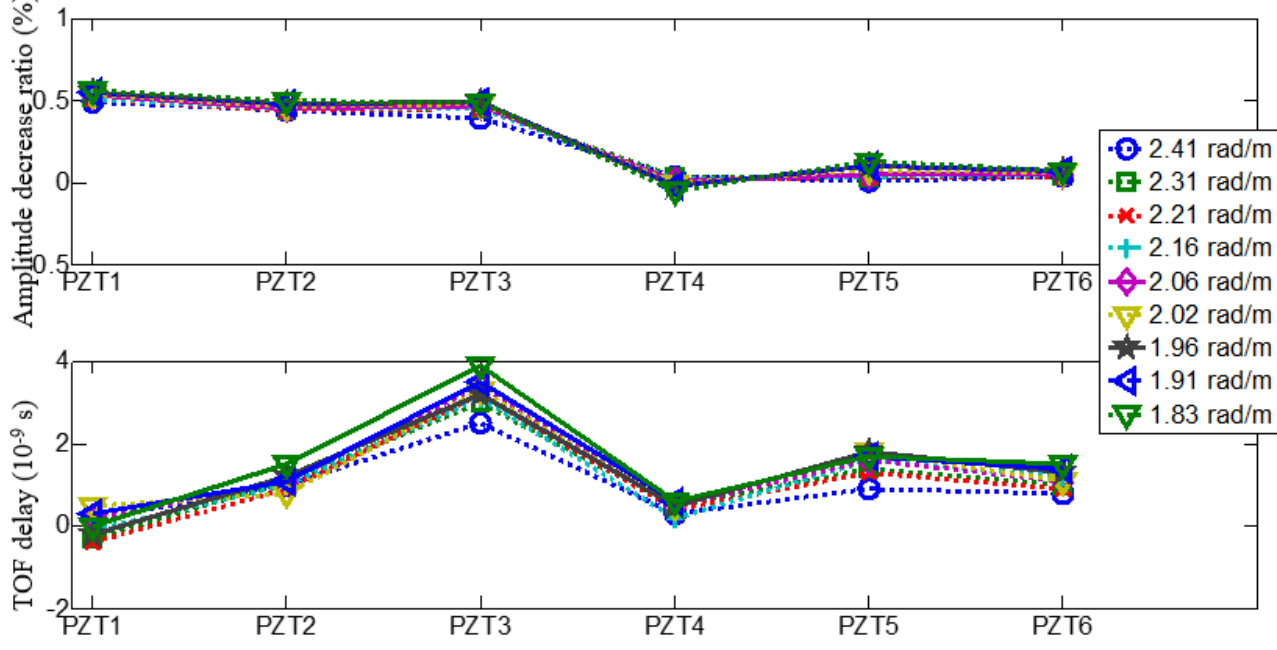
Figure 11. Schematic of experimental setup for load testing.